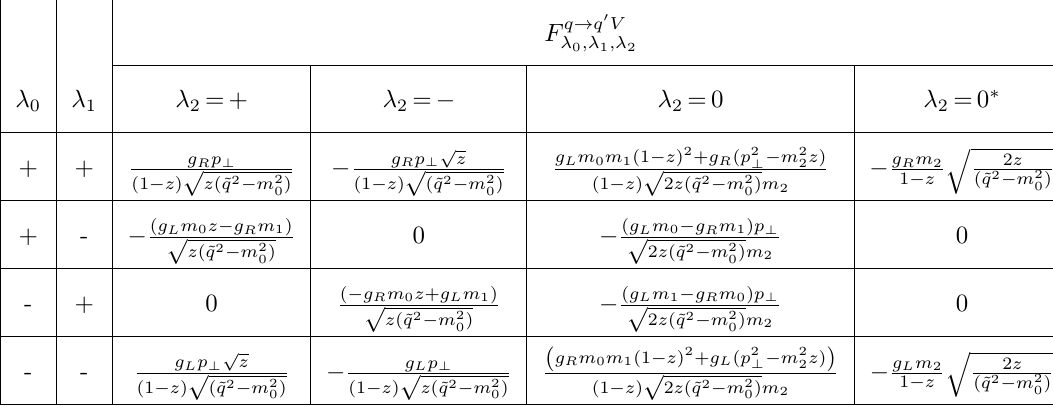
Table 1. Spin-unaveraged splitting functions for q → q 0 V . In addition to the factors given above, each term has a phase e i ( λ 0 − λ 1 − λ 2 ) φ 0 , where λ 2 = ± 1 and λ 0 , 1 = ± 1 of the outgoing EW guage vector boson and the quarks respectivey. The longitudinal polarization states, which are marked as λ 2 = 0 ∗ , give the relevant components in Dawson’s approach [54] and can be used to eliminate singularities that appear in the p ⊥ (cid:29) m 2